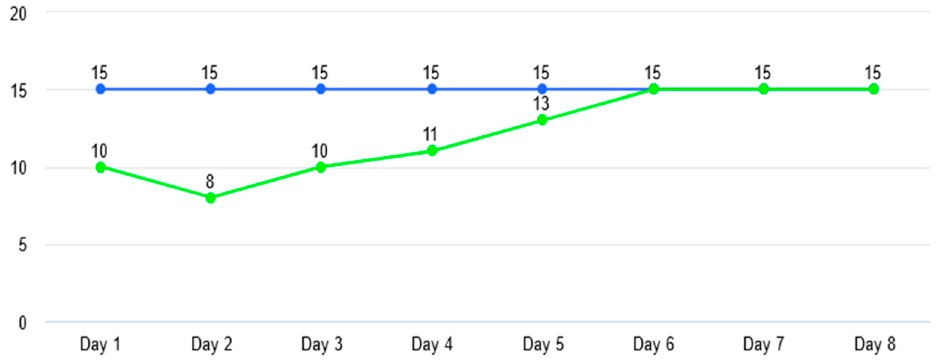
Figure 10. Evolution of detections. Blue line represents the real number of defects provided to algorithm and the green line represents the defects detected by the algorithm over 8 days.